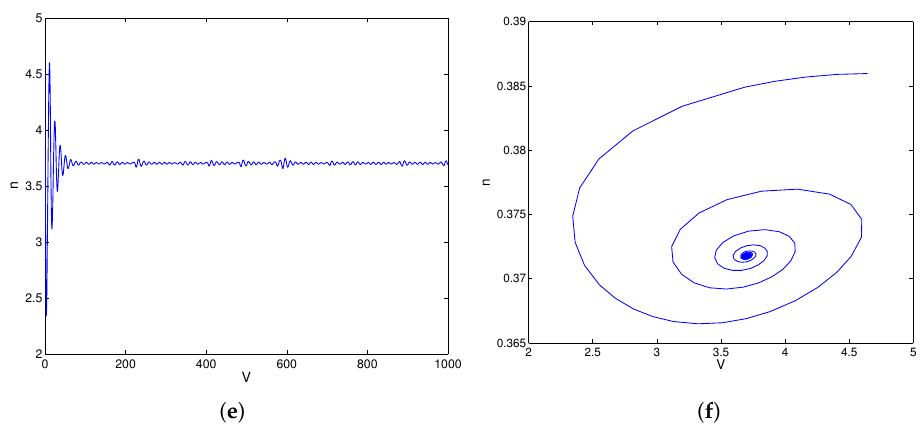
Figure 3. The convergent behaviors of model (28) about parameter V E . ( a ) Response curve of trans- membrane voltage V for V E = − 6.284. ( b ) Trajectories in V − n phase plane for V E = − 6.284. ( c ) Response curve of trans-membrane voltage V for V E = − 6.265. ( d ) Trajectories in V − n phase plane for V E = − 6.265. ( e ) Response curve of trans-membrane voltage V for V E = − 5.6. ( f ) Trajecto- ries in V − n phase plane for V E = −